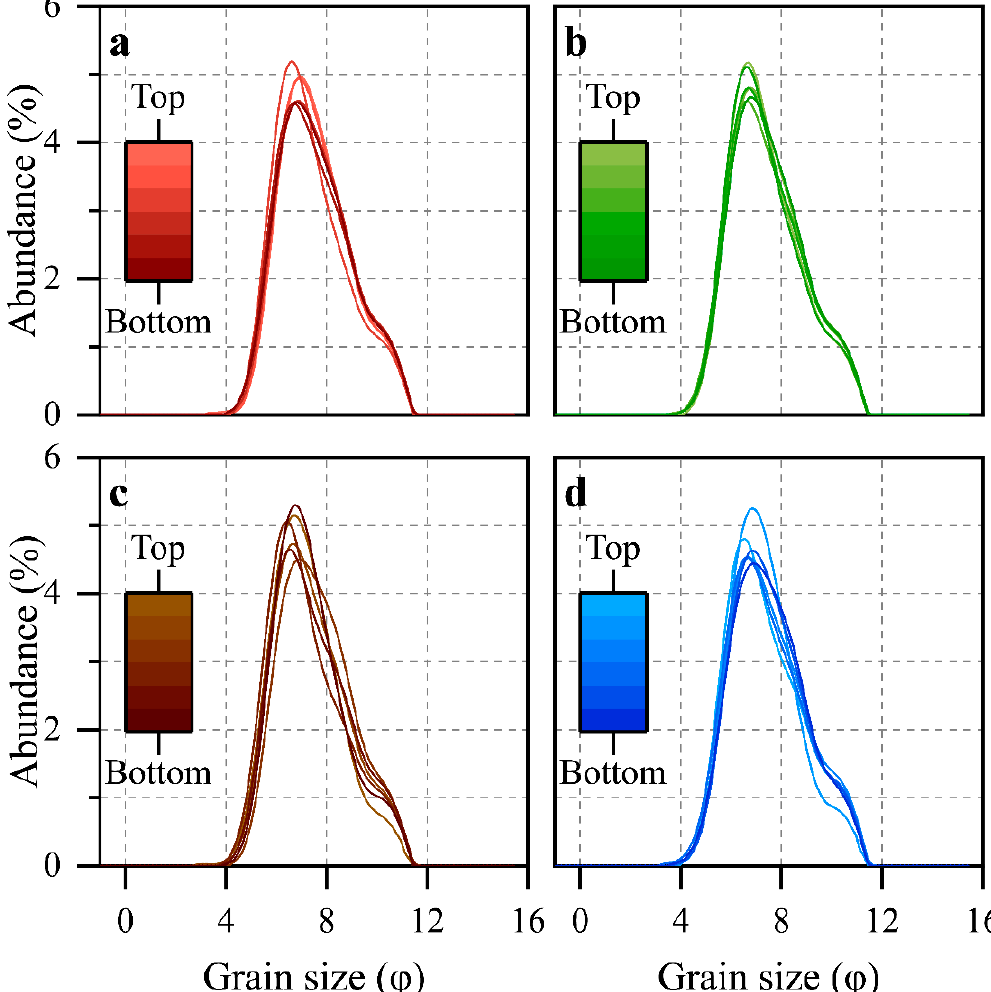
Figure 2. Grain size distribution along sediment cores collected from mangrove M1 at stations ( a ) L1 (old mangrove) and ( b ) S1 (salt marsh stand); and mangrove M2 at stations ( c ) L2 (young mangrove) and ( d ) S2 (bare mudflat). Top and bottom indicate the surface layer and bottom layer of the sediment cores, respectively.